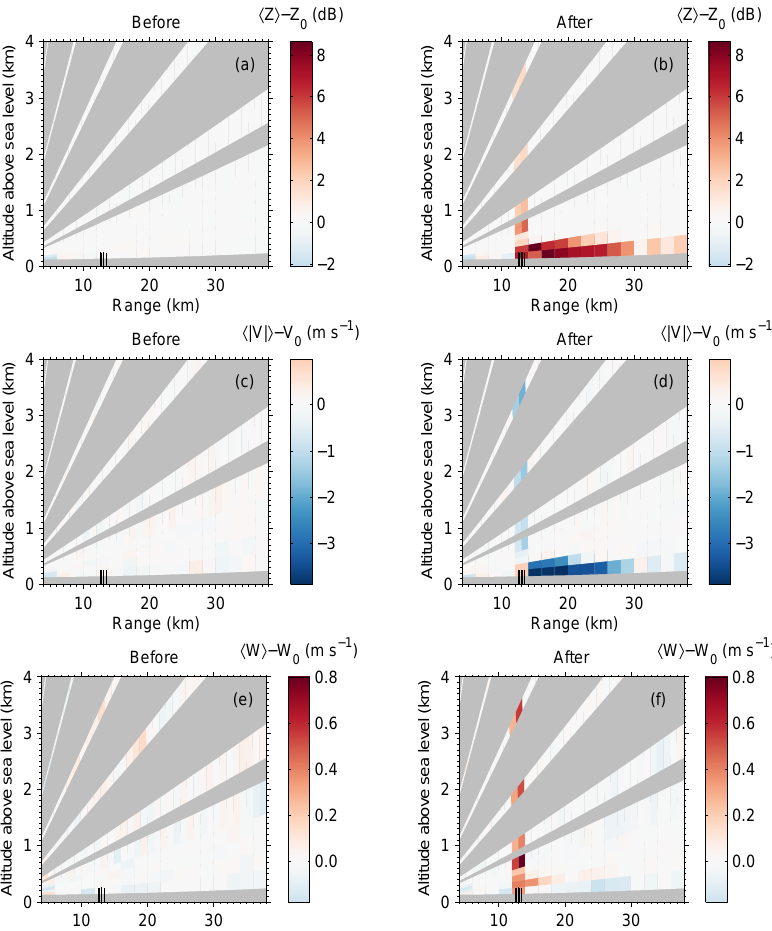
Figure 5. Difference in average reflectivity, (cid:104) Z (cid:105)− Z 0 ; difference in average absolute radial velocity, (cid:104)| V |(cid:105)− V 0 ; and difference in average spectrum width, (cid:104) W (cid:105)− W 0 , for all tilt angles (0 . 5 ◦ ≤ θ ≤ 40 ◦ ) before and after the construction of the Brunsmo wind farm. For each scan, Z 0 , V 0 , and W 0 were calculated as the mean value in azimuth (for the azimuth gates shown in Fig. 4) of the corresponding spectral moment before the construction of the wind farm. Data were taken from azimuth gate 52, the gate in which three wind turbines are located (near 44 ◦ azimuth). The locations of the wind turbines are shown on the bottom of each plot as black vertical lines. The wind turbines are only in the radar line of sight for the scan with the lowest tilt angle but are nevertheless seen to impact scans with higher tilt